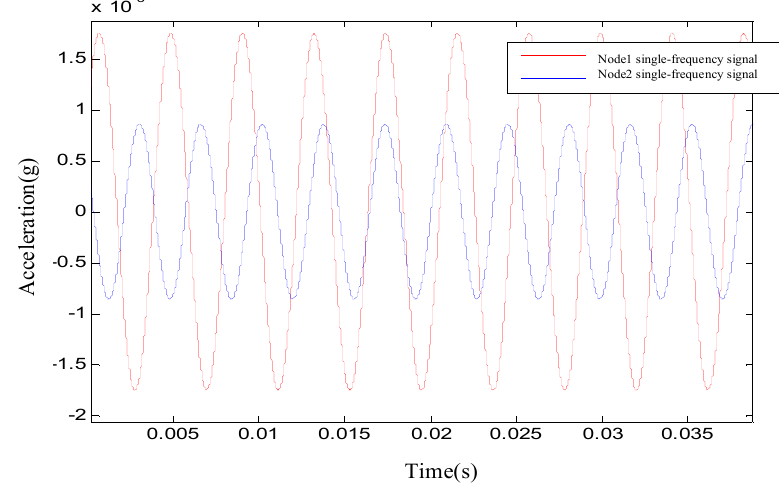
Figure 21. Time domain waveform of two nodes at the dominant frequency.